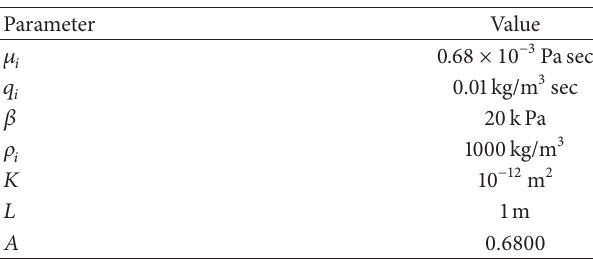
Table 2: Values of different